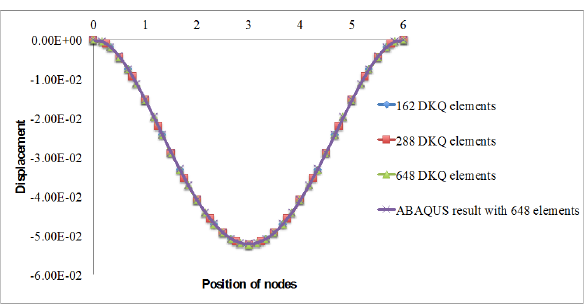
Figure 8: Transverse displacement u 3 distribution along the long edge for a single-layer shell with DKQ elements.